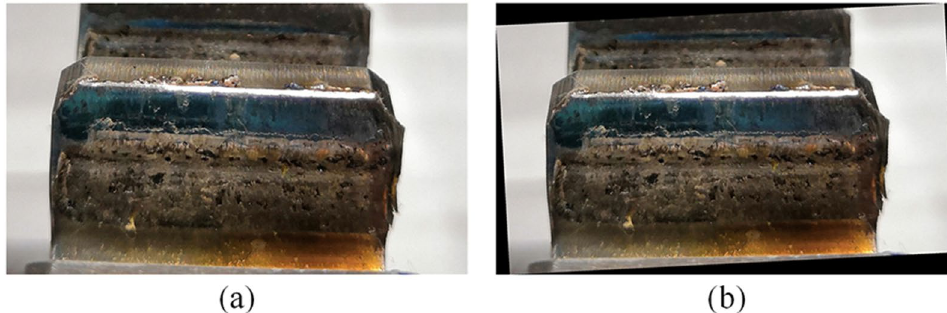
Figure 10 Comparison of gear tooth surface tilt correction: a original image, b result